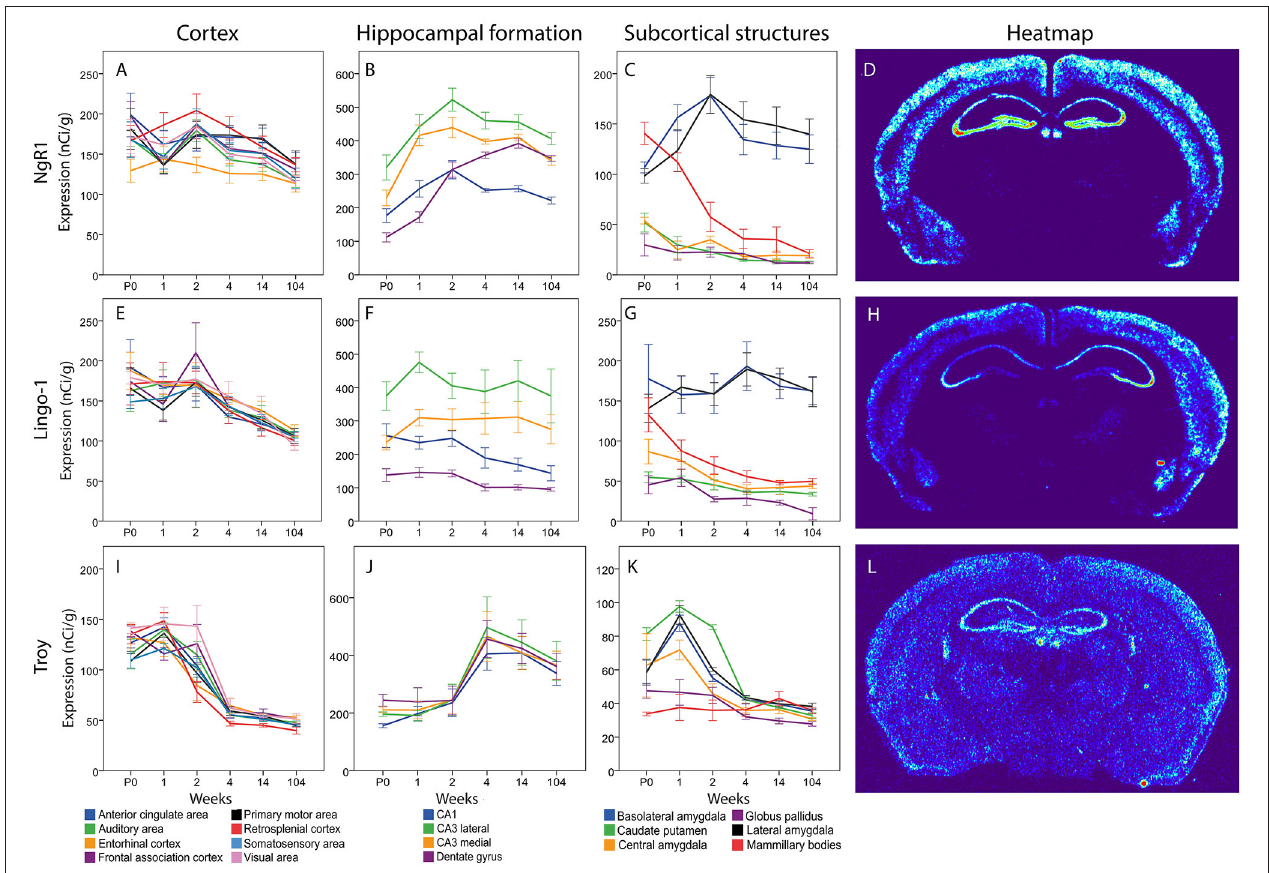
FIGURE 9 | NgR1 (A–C) , Lingo-1 (E–G) and Troy (I–K) mRNA levels in 18 brain regions over time. The x-axis indicates age in weeks, the y-axis indicates levels of mRNA expression in nCi/g, and is individual for each gene and region. Significant changes defined as p < 0,05 are mentioned in the text for each gene. Heatmaps of the three genes (D,H,L) visualizing expression in 14 week old mice.